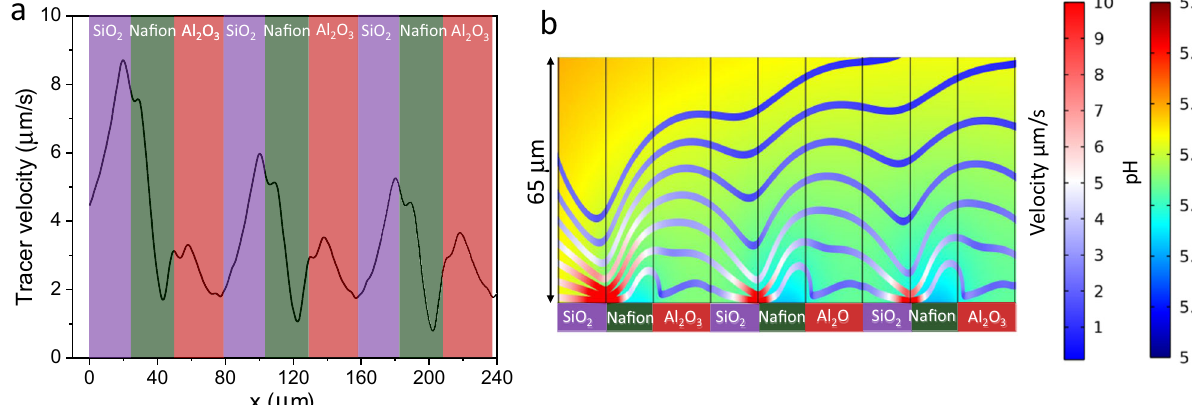
Fig. 5 Simulations of unidirectional micropumps. a Horizontal component of the expected velocity of a polystyrene tracer particle along the strip array composed by repetitive micropumps of SiO 2 /Na fi on/Al 2 O 3 . The tracer velocity was obtained from the simulations at 3 µ m above the surface and was smoothed using a 5 µ m moving average. Source data are provided as a Source Data fi le. b pH mapping (color scale) and streamlines of the fl uid fl ow over the fi rst three repetitions of the periodic structure. The streamlines are colored by the local value of the fl uid velocity, and illustrate the variations in speed caused by the local pumping triggered by the Na fi on